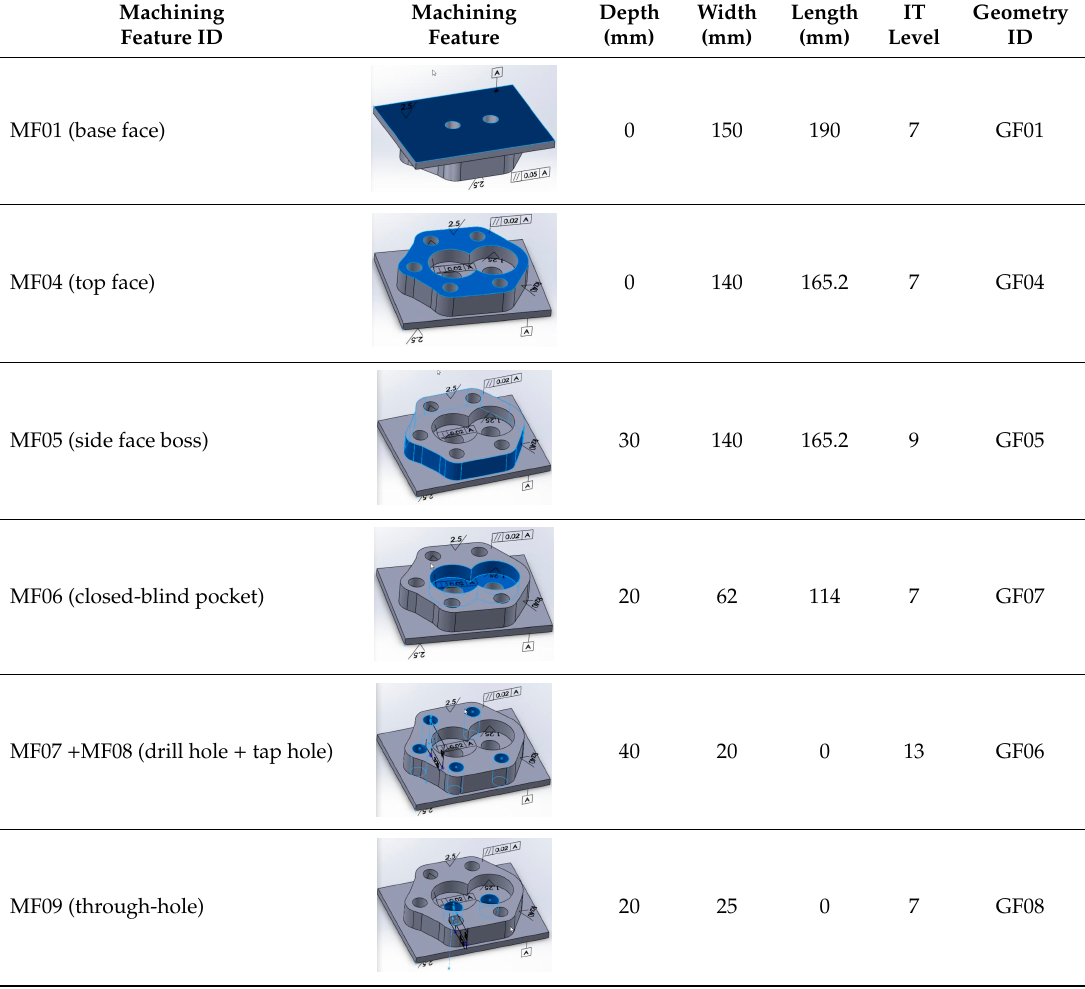
Table 4. Machining feature and technical requirement recognition results.